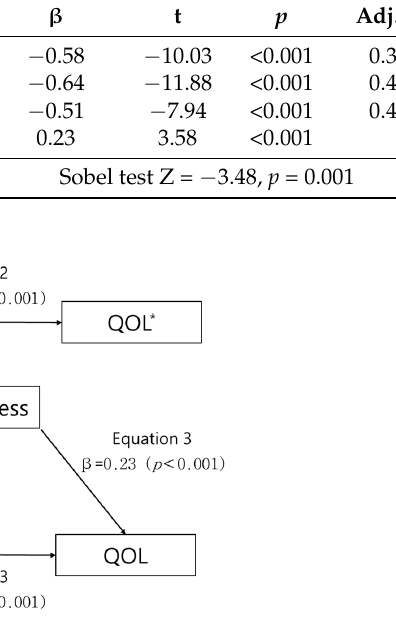
Table 4. Mediating effect of mindfulness ( N = 206).